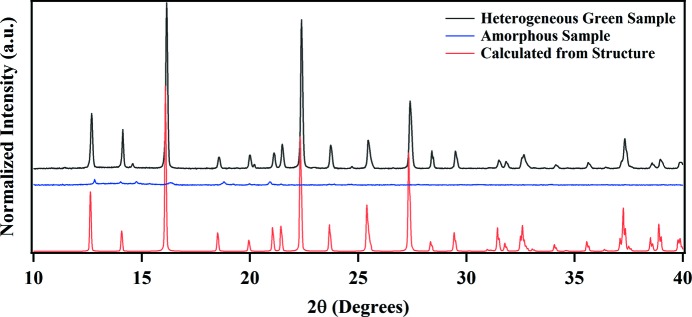
PXRD patterns for the heterogeneous green sample containing both crystalline and amorphous material (black), the sample containing the isolated green amorphous material (blue), together with the PXRD pattern expected from our single-crystal structure of [meoenH]Cu2(CN)3 (red), calculated from GSAS II (Toby et al., 2013 ▸).